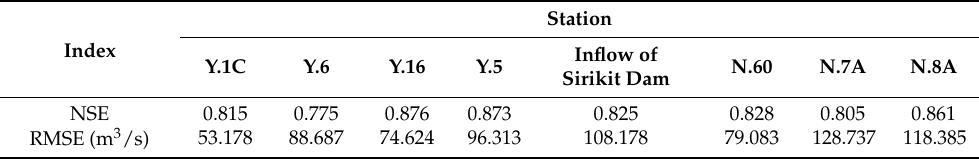
Table 3. Values of the Nash–Sutcliffe model Efficiency (NSE) and Root Mean Square Error (RMSE) for the validation period